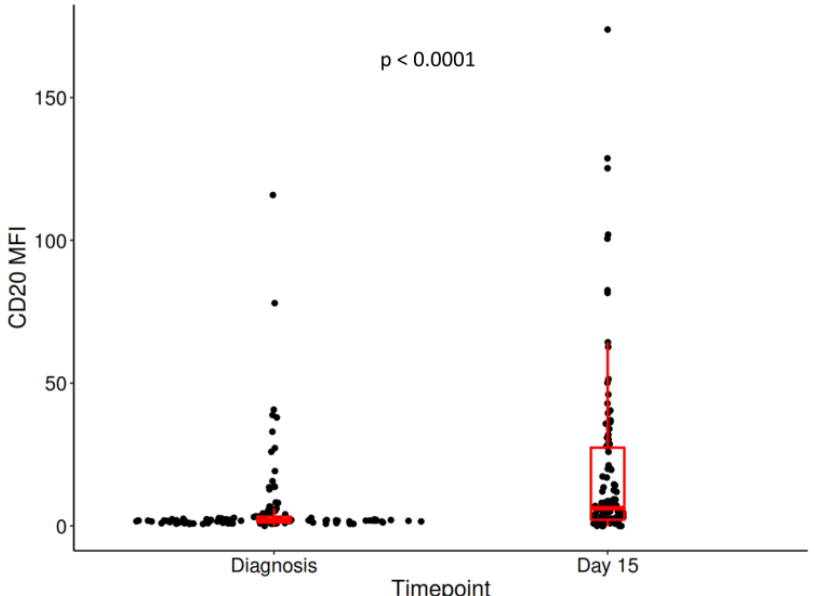
Figure 1. The difference in CD20 MFI between diagnosis and day 15. Centrality and dispersion measures were represented in the form of box and whiskers.